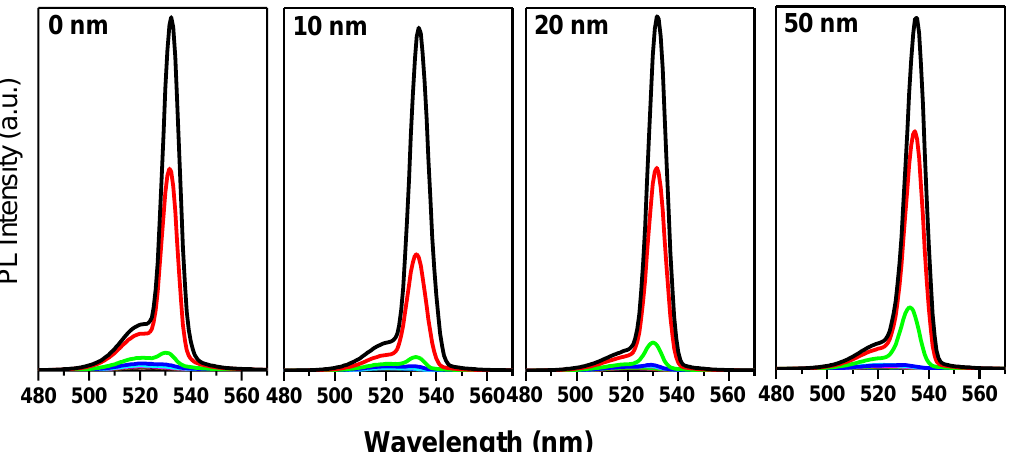
Figure 5. The evolution of PL spectra with pulse energy density of the pump under 410 nm excitation of the pure PQDs CsPbBr 3 and CsPbBr 3 PQDs/c-TiO 2 films of 0, 10, 20, and 50 nm c-TiO 2 thickness respectively. (black for 24 µ J/cm 2 , red for 23.5 µ J/cm 2 , green for 23 µ J/cm 2 , blue for 22.5 µ J/cm 2 , and cyan for 22 µ J/cm 2 ; other lower densities between 19 and 21.5 µ J/cm 2 are used in the measurements as well but are not shown here as the differences are